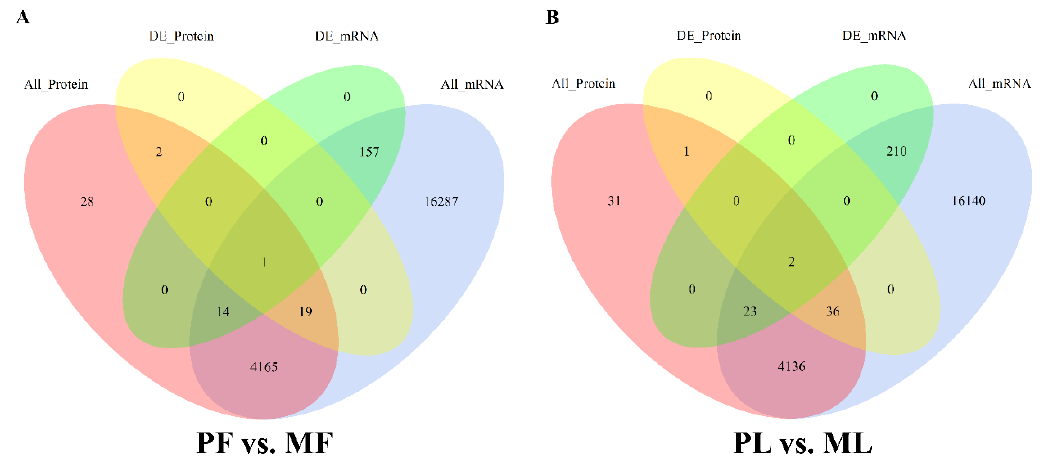
Figure 8. Venn diagram of the correlation between proteomics and transcriptomics in PF vs. MF ( A ) and PL vs. ML ( B ).